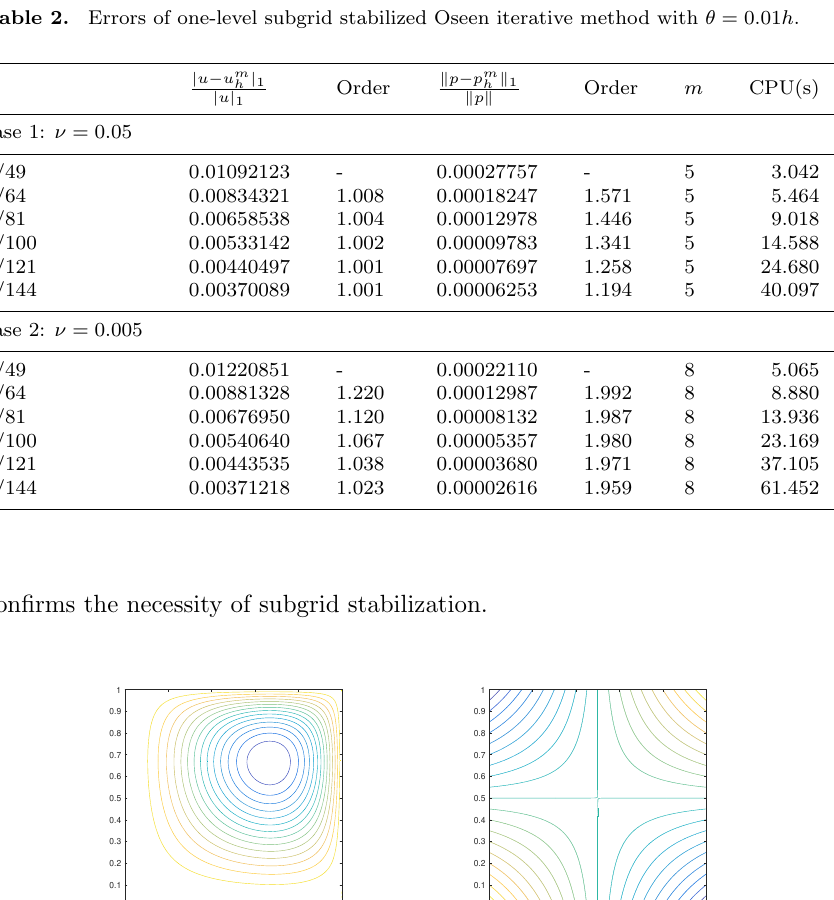
Table 2. Errors of one-level subgrid stabilized Oseen iterative method with θ = 0 . 01 h .